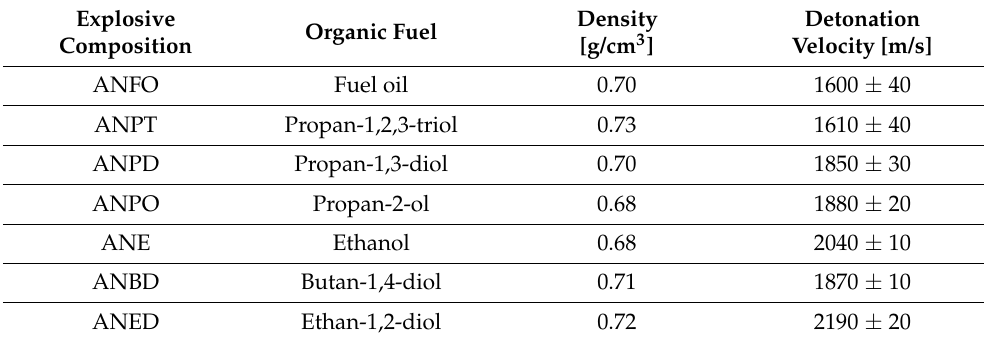
Table 6. Results of measurements of detonation velocity of AN/organic fuel compositions.